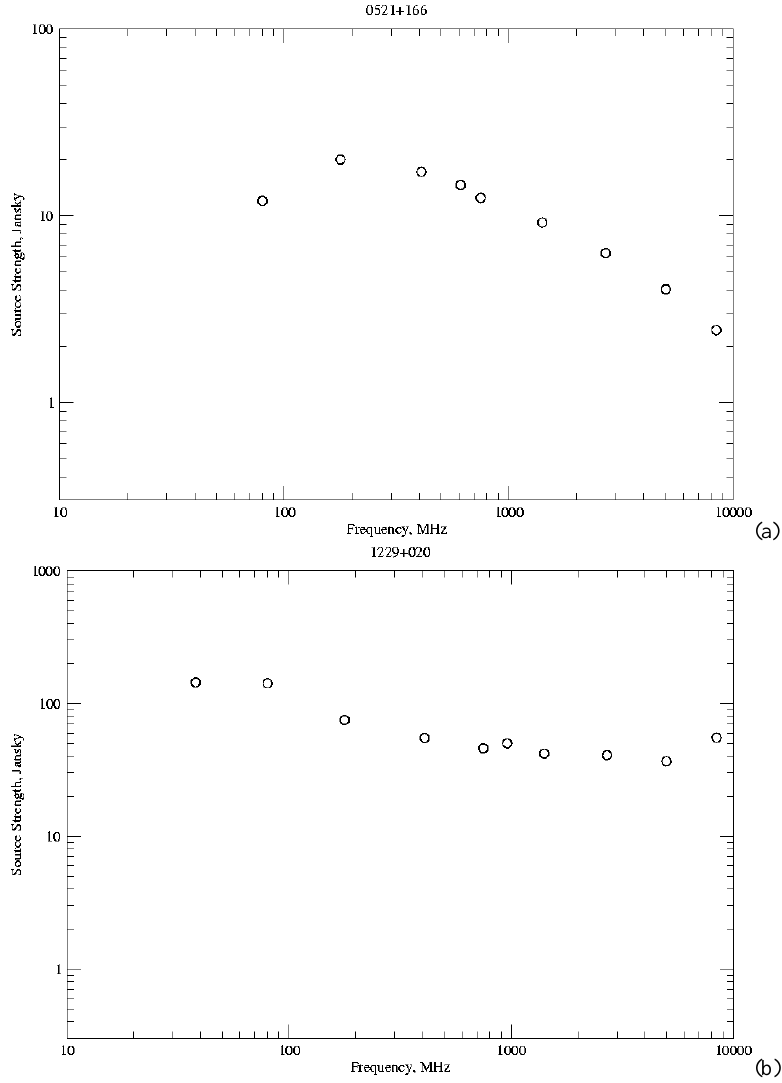
Fig. 2. Log-log plots of F S versus ob- serving frequency for radio sources: (a) 0521 + 166, and (b) 1229 +